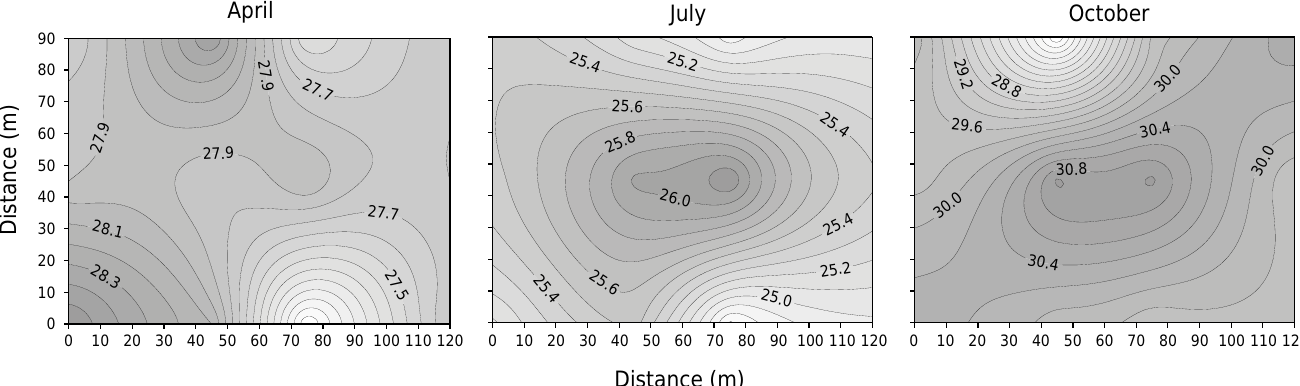
Figure 4. Spatial distribution of soil monthly mean temperature at a 0.05 m depth of a Cambissolo Háplico Ta Eutrófico (Cambisol; Inceptisol) for April, July, and October, from February 04, 2014 to September 30, 2015 in São Gabriel, Irecê Identity Territory, Bahia,